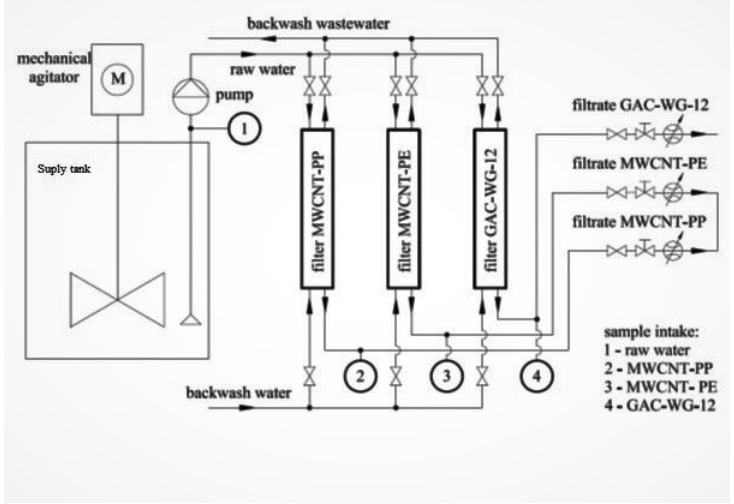
Figure 3. Place of water